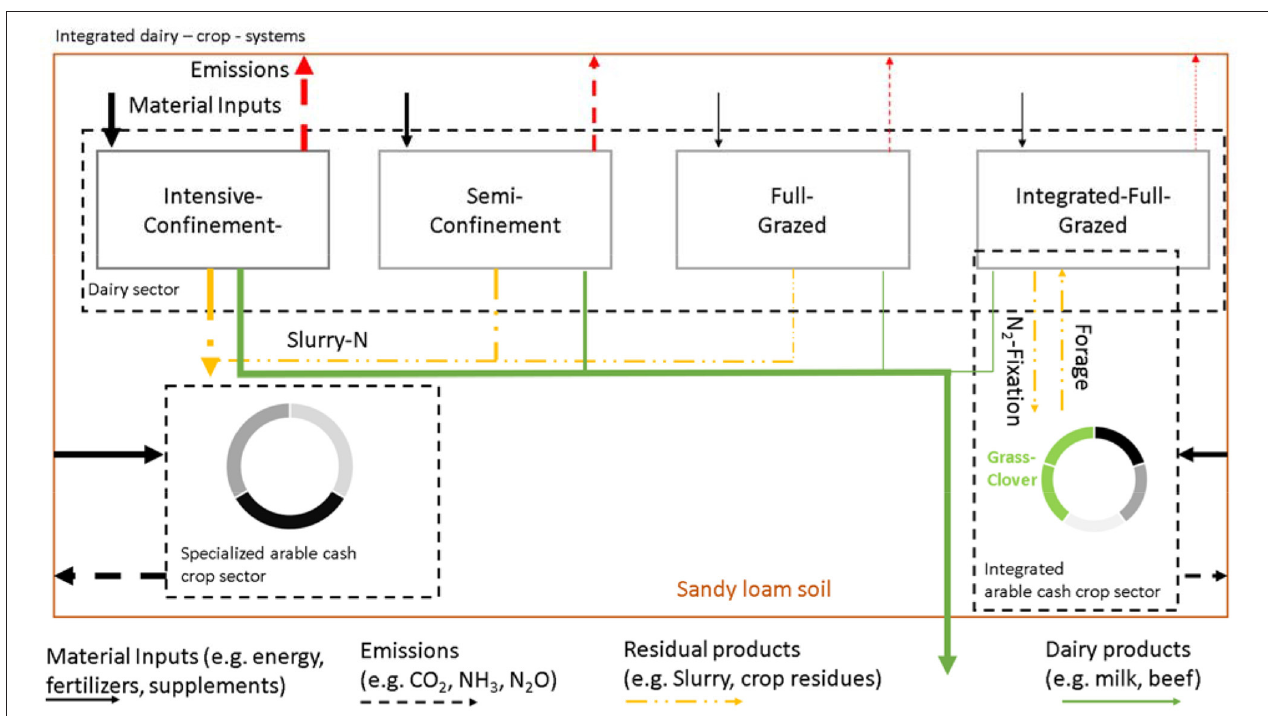
FIGURE 1 | Assumption of input and emission flows within the prevailing dairy systems. The system boundaries indicate the scope of the conducted farm